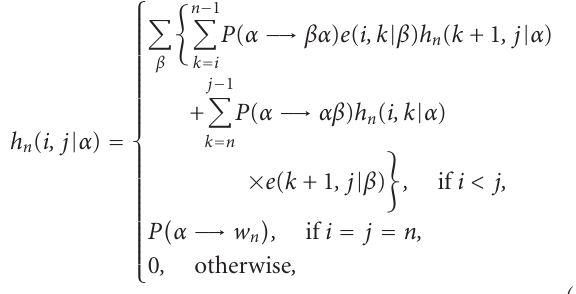
Algorithm 1. (1) Definition of symbols and